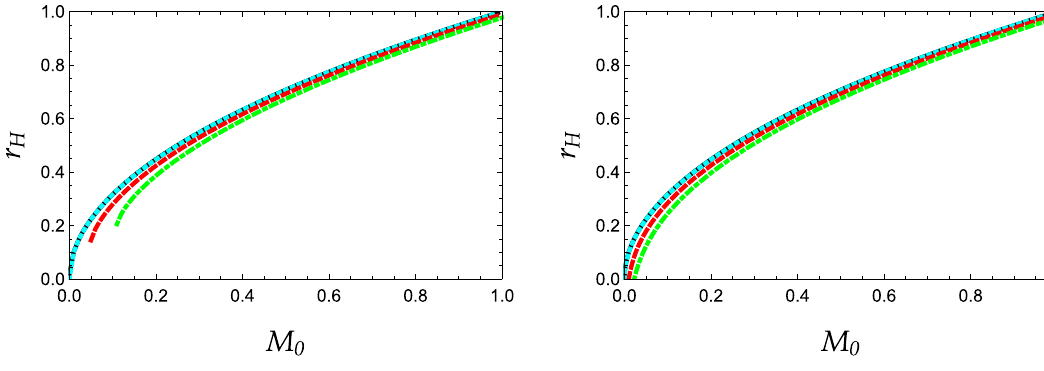
Fig. 3 Black hole horizon r H against the classical black hole mass M 0 for different values of the parameter ξ . Left panel: Exact black hole horizon obtained numerically by solving B ( r H ) − 1 = 0, versus M 0 . Right panel: Approximated horizon obtained for a small value of the